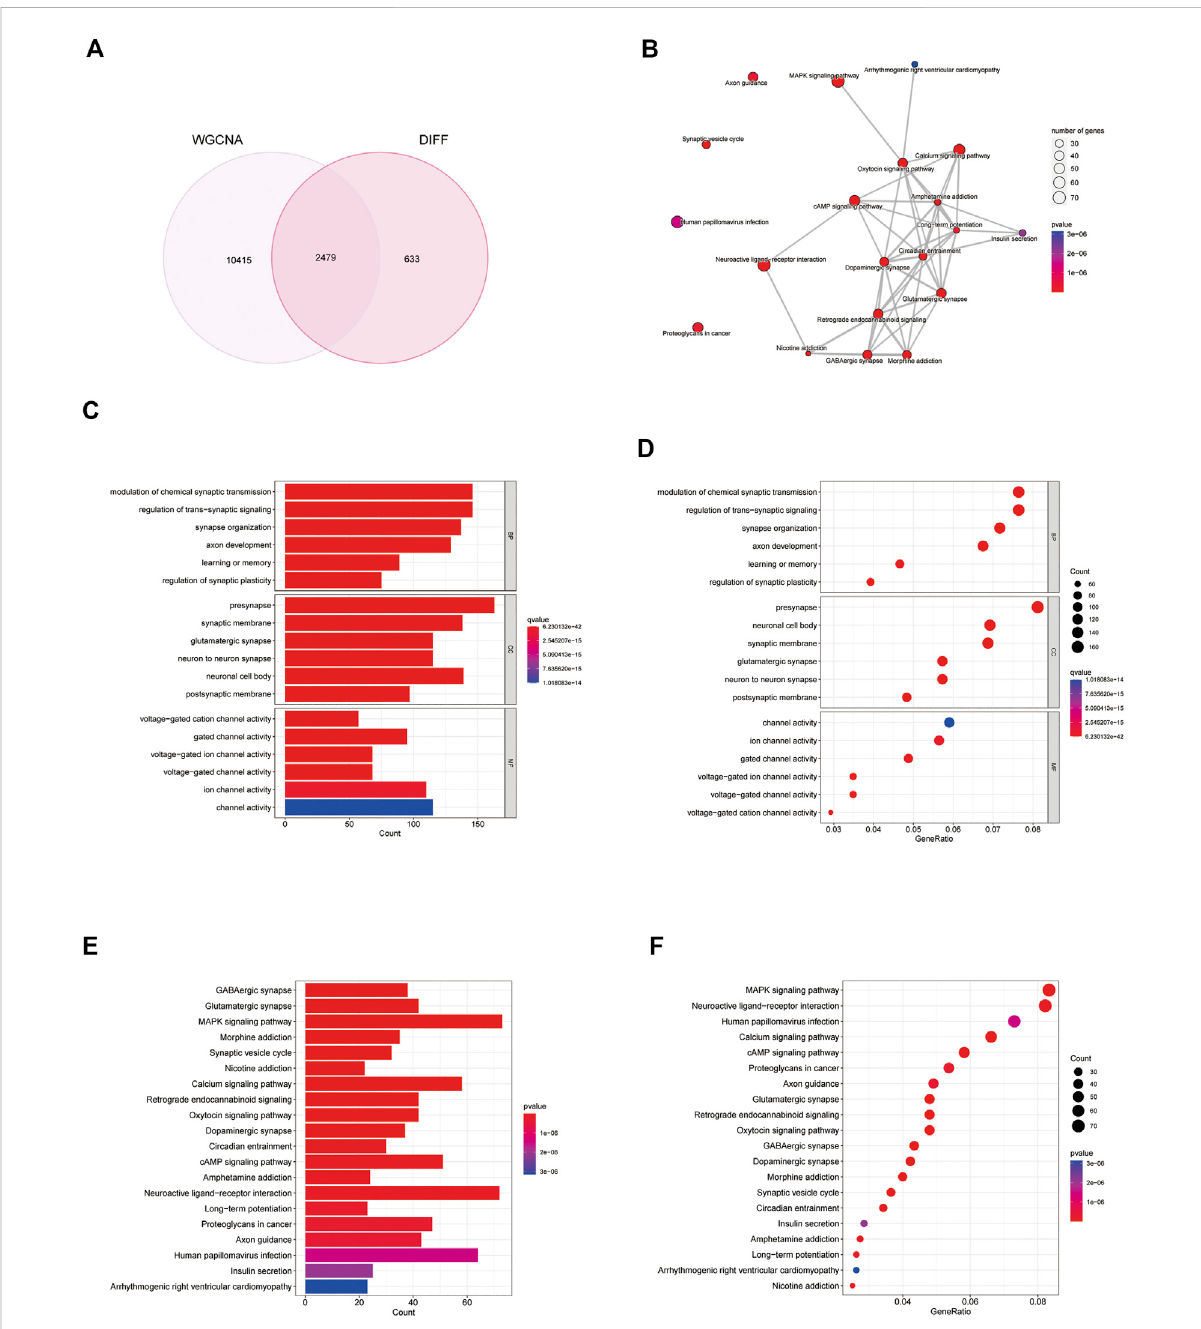
FIGURE 5 Analysis of differential genes and weighted gene co-expression network analysis (WGCNA) genes. (A) Venn diagram of differential genes and WGCNA genes. (B – F) Gene Ontology (GO) and Kyoto Encyclopedia of Genes and Genomes (KEGG) analysis of disease genes.